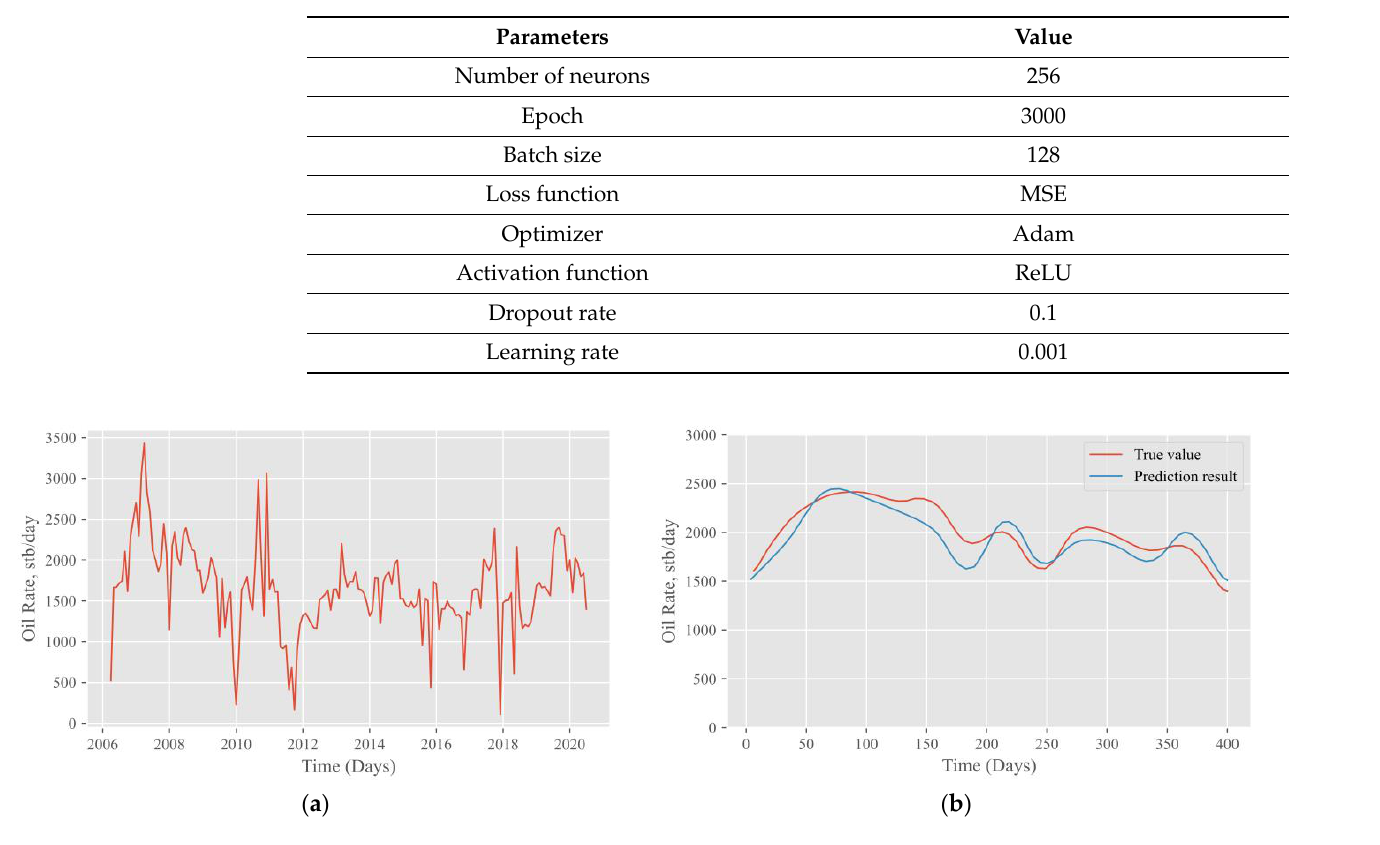
Figure 10. The predictive performance of oil production using GRU model: ( a ) The raw data from the numerical model; ( b ) The prediction result. Table 3. Error analysis of the prediction performance.